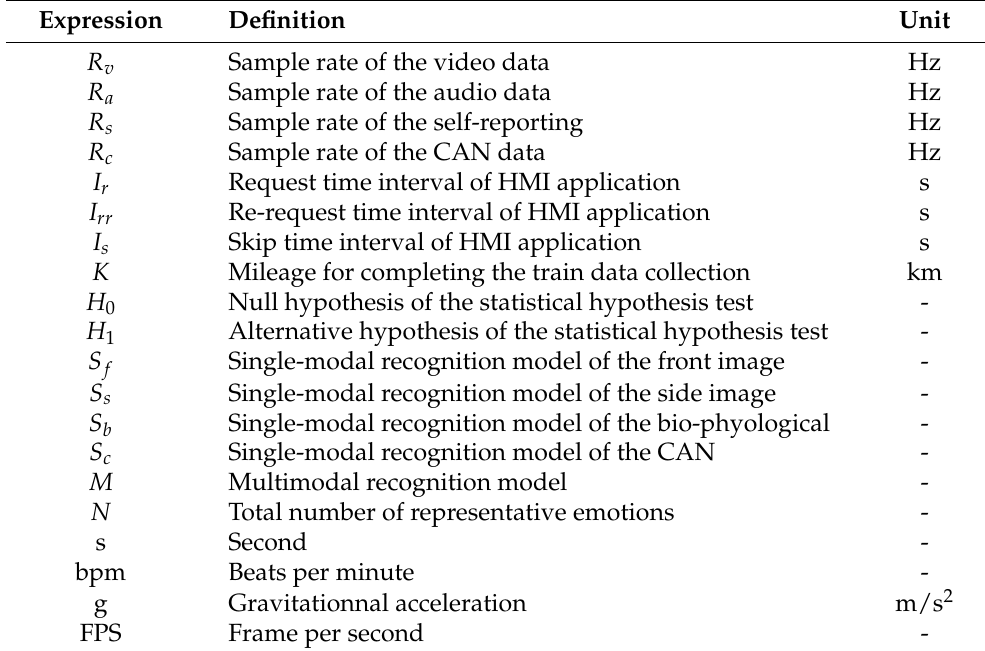
Table A1. Deficition of terminologies and variables used on the main